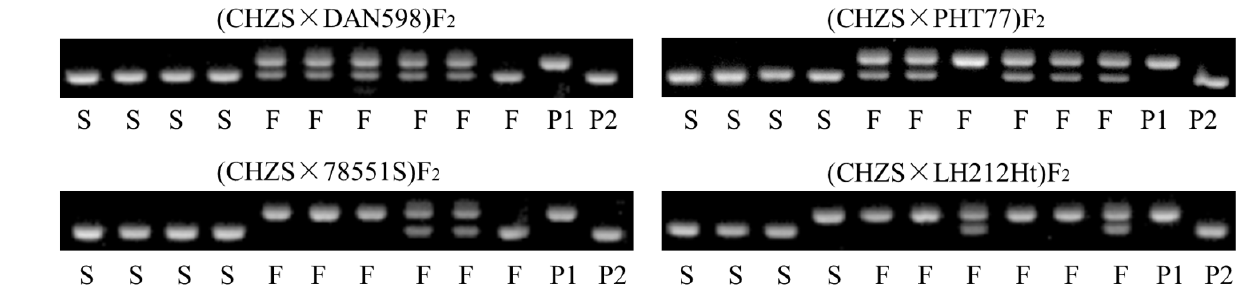
Figure 3. Electrophoresis analysis of b0329 marker in some F 2 individuals, derived from the cross between CHZS and the tester lines. F, fertile individuals; S, sterile individuals; P1, fertile parents; P2, the CMS-C line, CHZS. Table 5. Percentage of recombinants (%) in the F 2 populations, assessed by b0329 and S-4 markers. No. of Fertile Populations